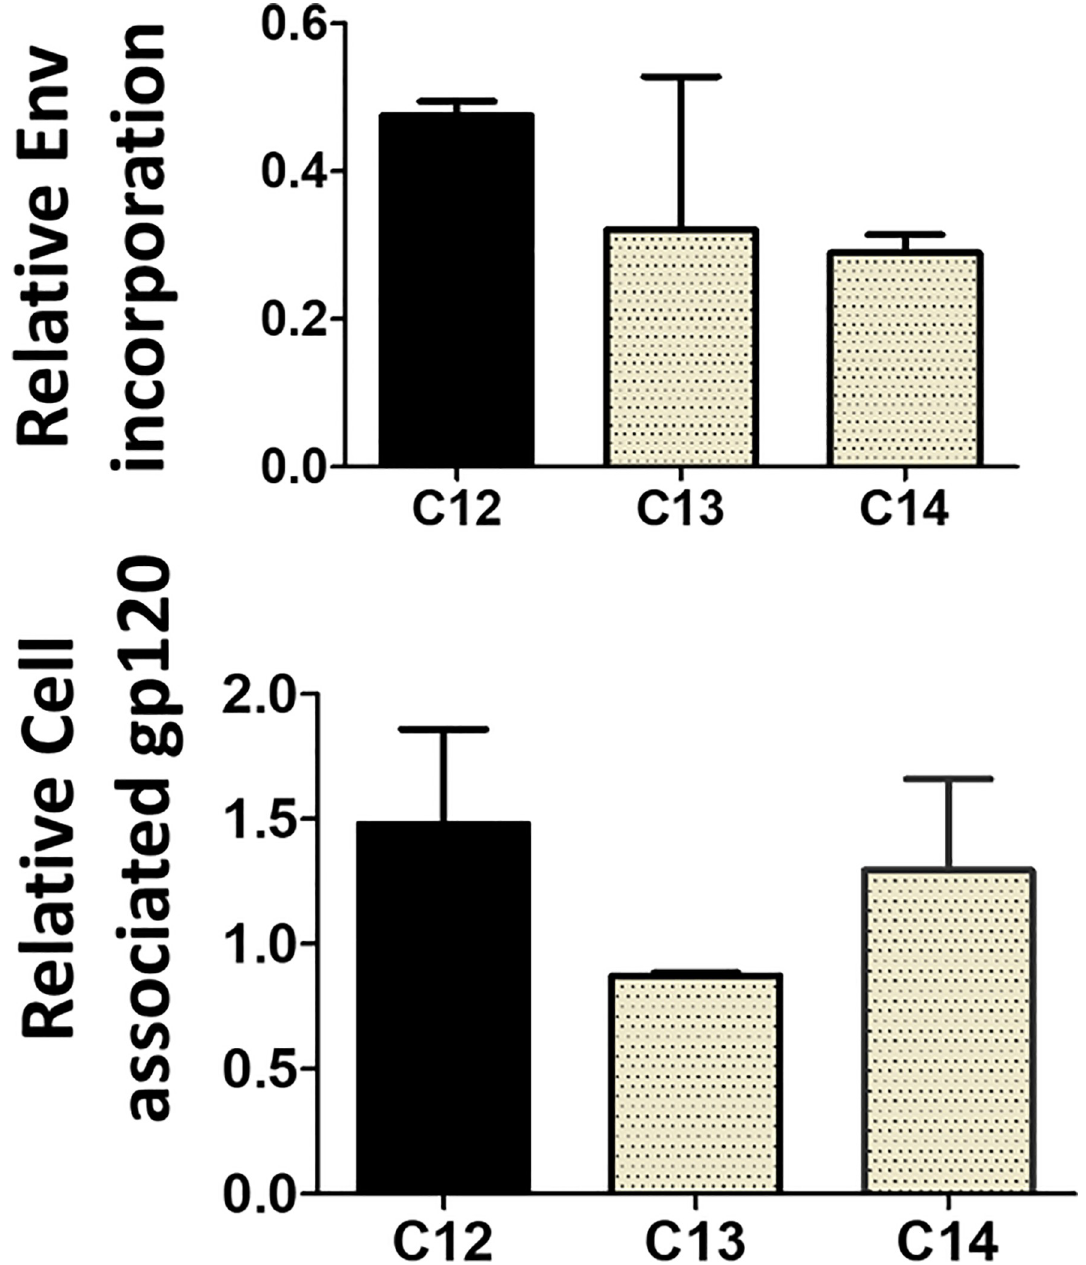
Fig 3. Env expression and incorporation into pseudovirus. HEK 293T cells were co-transfected with pSG3 Δ env and C12, C13 or C14 env. The culture medium was harvested and the cells lysed for SDS PAGE and Western blotting. A) Culture medium was ultracentrifuged to concentrate pseudovirus (PSV) and B) 100 μ g cell lysate were probed with anti-sheep gp120 antibody. β -actin and p24 were detected as loading controls for Env expression and PSV incorporation, respectively. The average levels of C12, C13 and C14 from two independent experiments were normalised to β -actin and p24 and compared using one-way Anova (Prism 5.0).